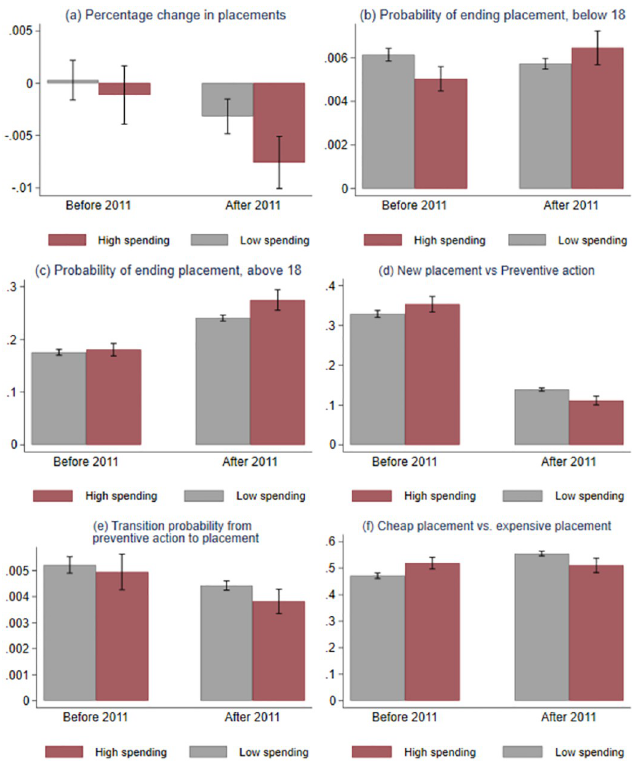
Fig 3. The monthly probability of ending and initiating out-of-home placements. High (Low) spending municipalities in year t are defined as municipalities that in year t have spent more (less) than 60 percent of the annual budget by July 1 st . Panel (a): Outcome is changes in log number of children in care. Panel (b) and (c): Outcome variable is monthly probability of ending an out-of-home placement for children below (above) 18. Panel (d): Outcome variable is monthly probability of initiating an out-of-home placement. Panel (e): Outcome is probability for a child (below 18) who is not currently receiving preventive actions and the left panel is for a child that receive preventive actions. Panel (f): Outcome is probability of choosing a “cheap” placement instead of an expensive placement. Confidence bands at 0.05 level.